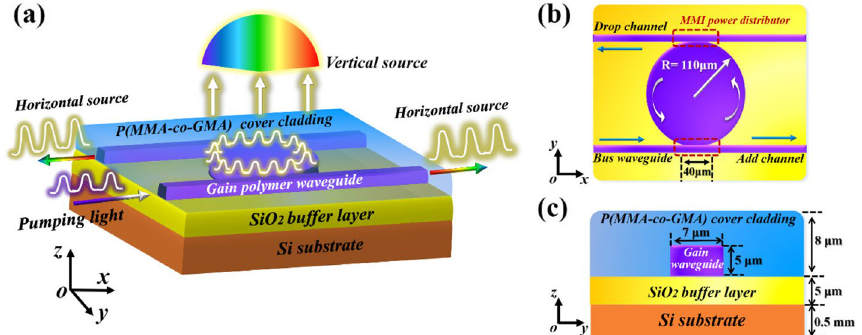
Fig. 2 Schematic diagram of the 3D photonic integrated optical sources. a The schematic architecture and operating principle of the microdisk-based on-chip optically pumping light sources; b structural parameters of the microdisk-based waveguide resonator in x – y profiles; c the size of cross-sectional gain waveguide